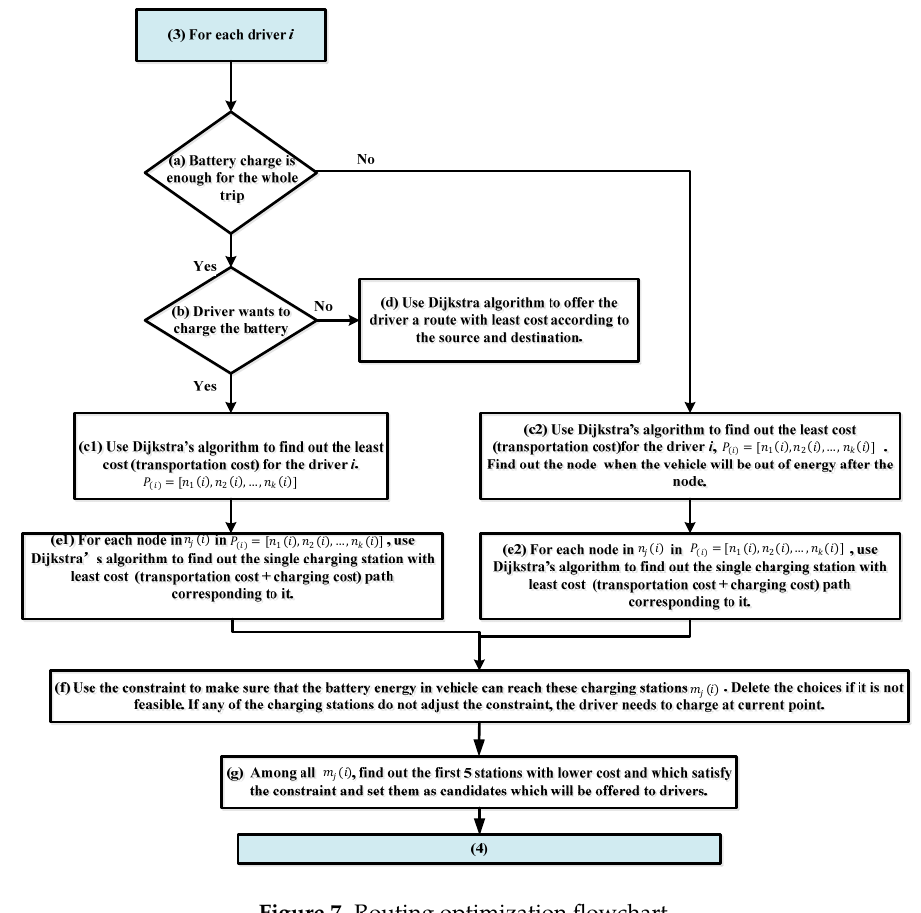
Figure 7. Routing optimization flowchart.